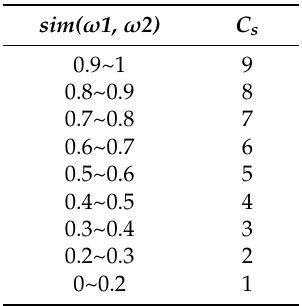
Table 3. Corresponding relation between lexical similarity range and C s